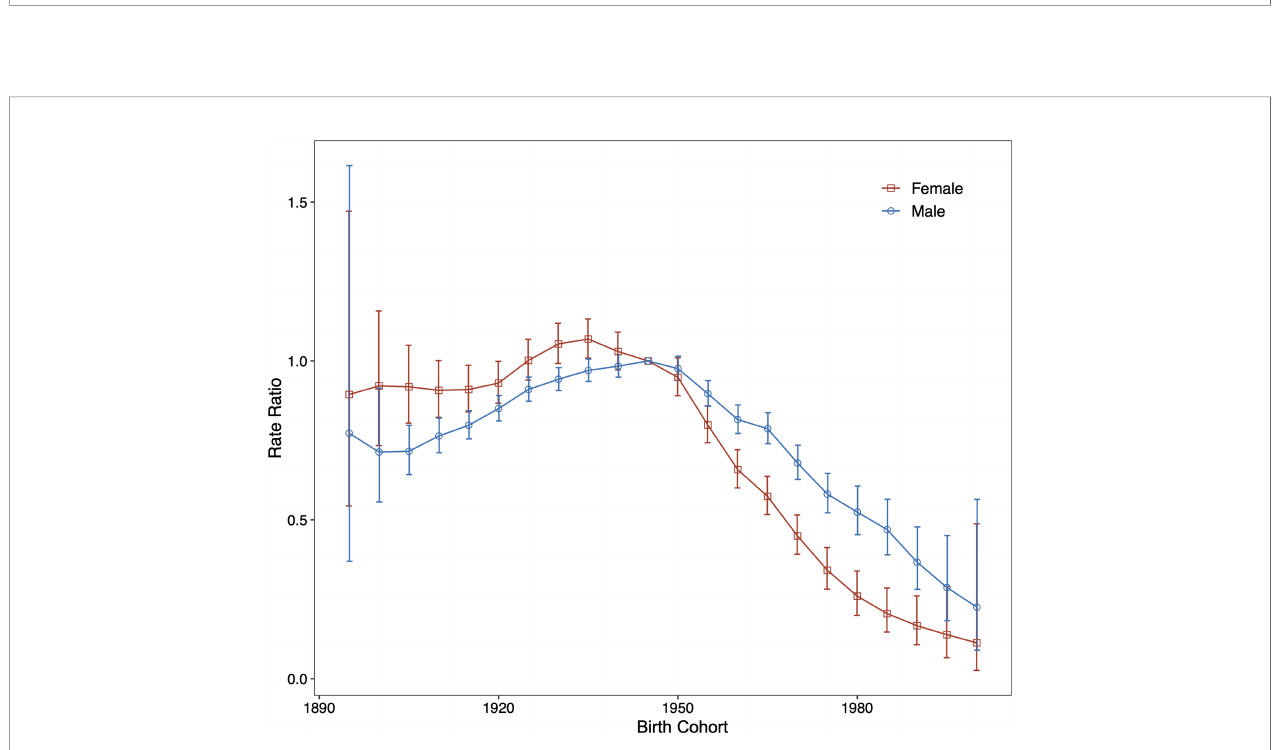
FIGURE 4 | Relative risk of each period compared with the reference period (2000 – 2004) adjusted for age and nonlinear cohort effects and the corresponding 95% con fi dence interval for males and